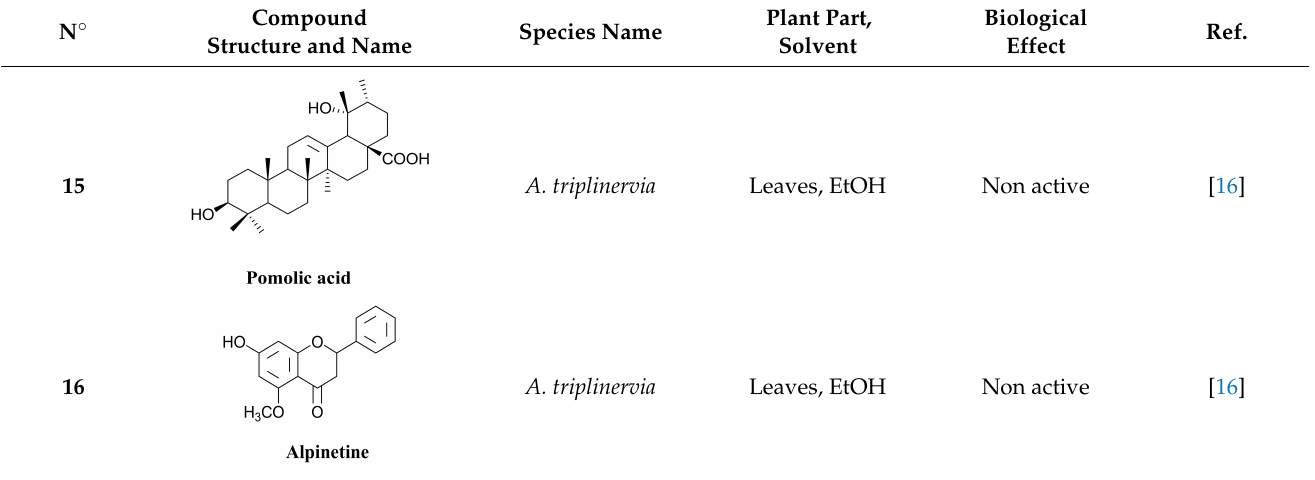
Table 3. Structure and bio-pharmacological properties of isolated compounds from A. triplinervia